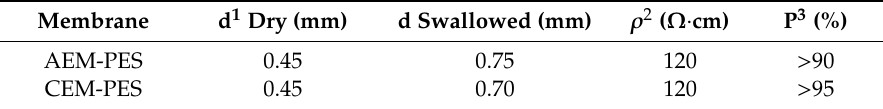
Table 3. Properties of the membranes used in